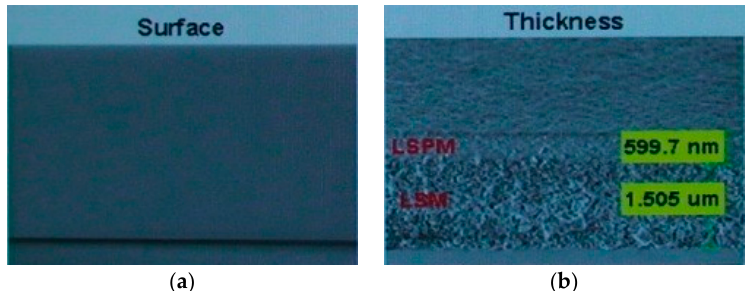
Figure 3. SEM images of the YSZ nanoparticle scattering layer (LSM) and the planarization layer (LSPM) after the curing process: ( a ) Top view of planarization layer; ( b ) Cross sectional view of the scattering layer and the planarization layer. Table 2. Transmittance and haze of the YSZ nanoparticle scattering layer.